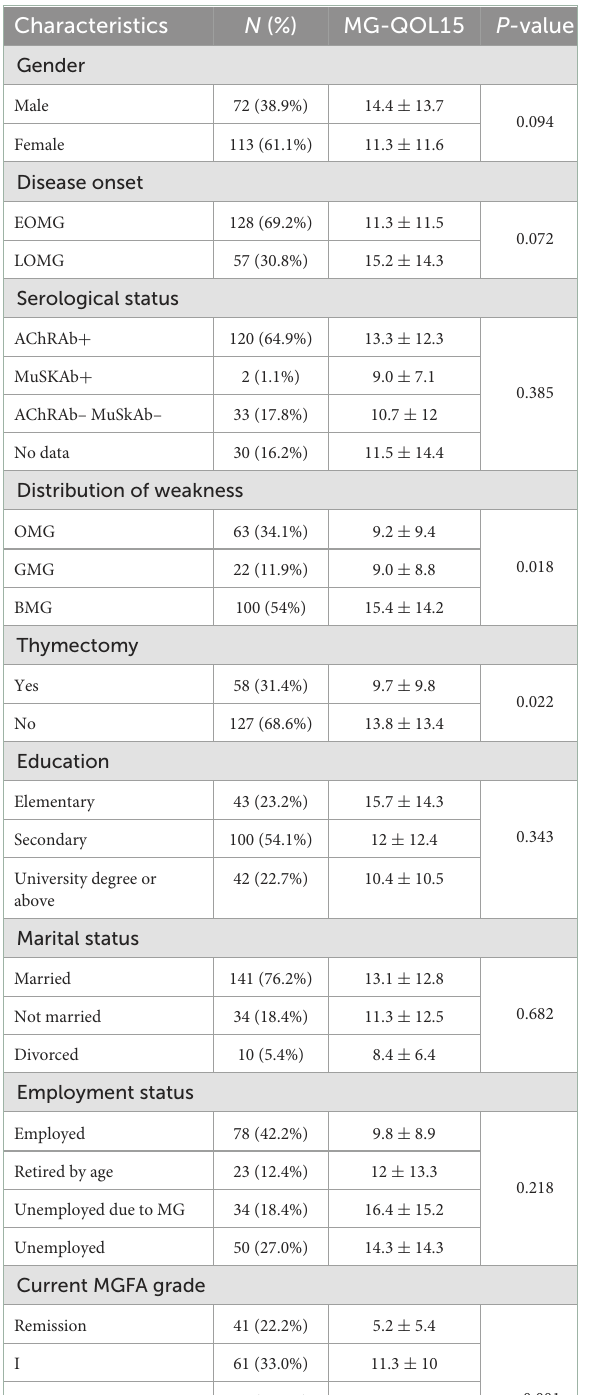
TABLE 1 Patient characteristics.